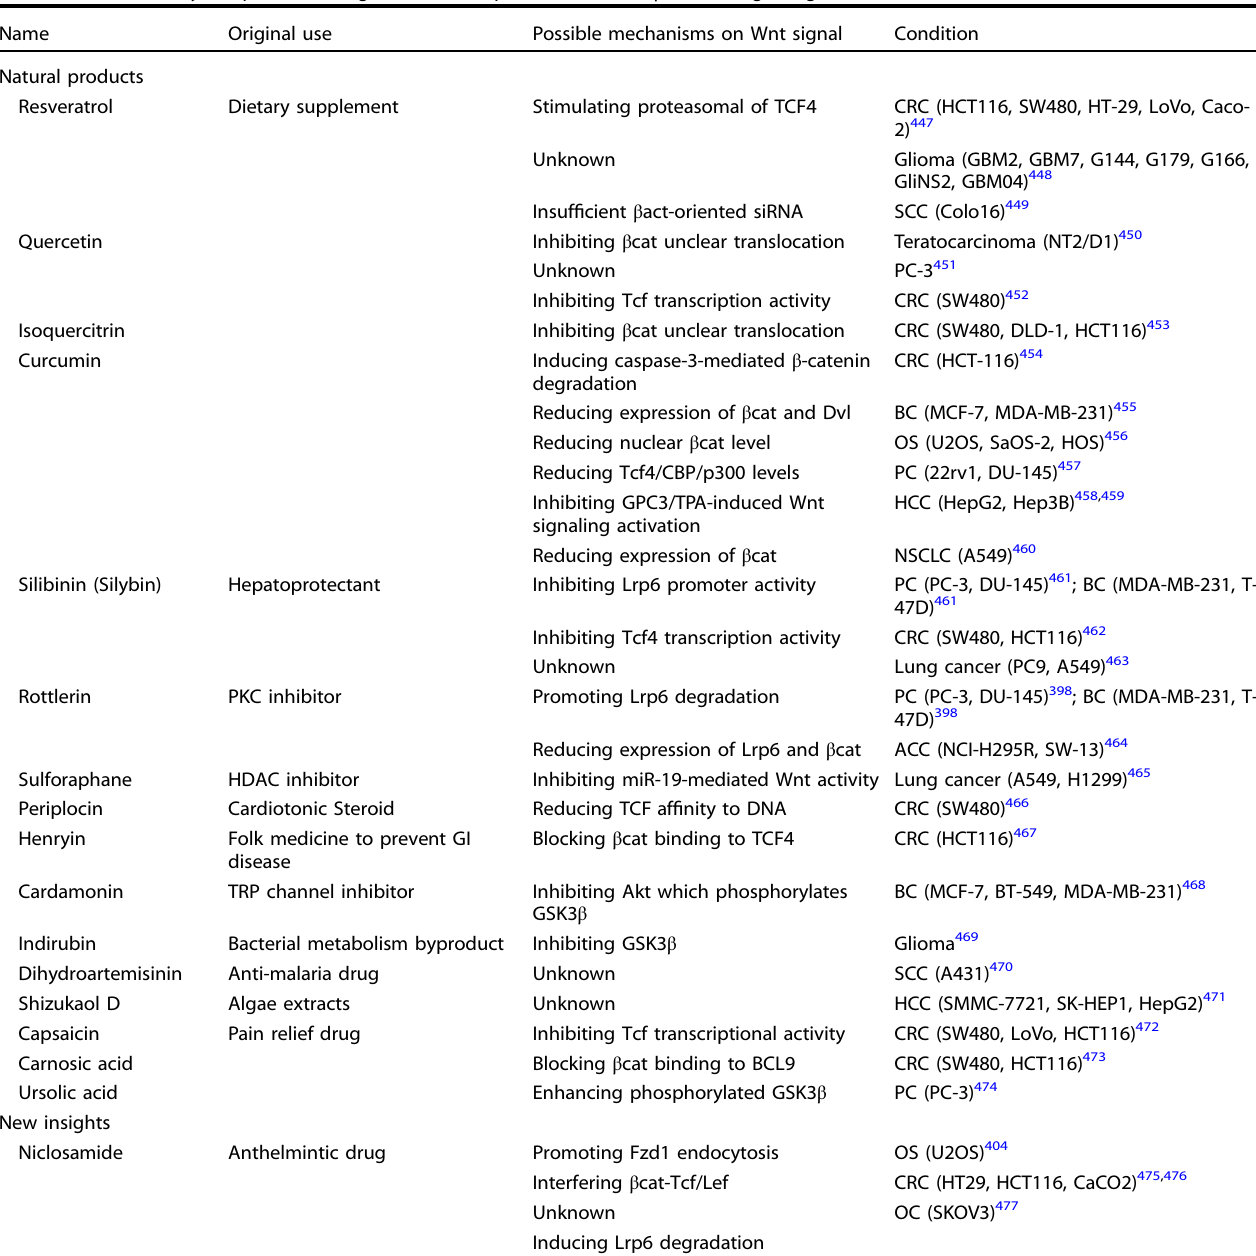
Table 3. The summary of up-to-date drugs that have implications on Wnt/ β -catenin signaling in